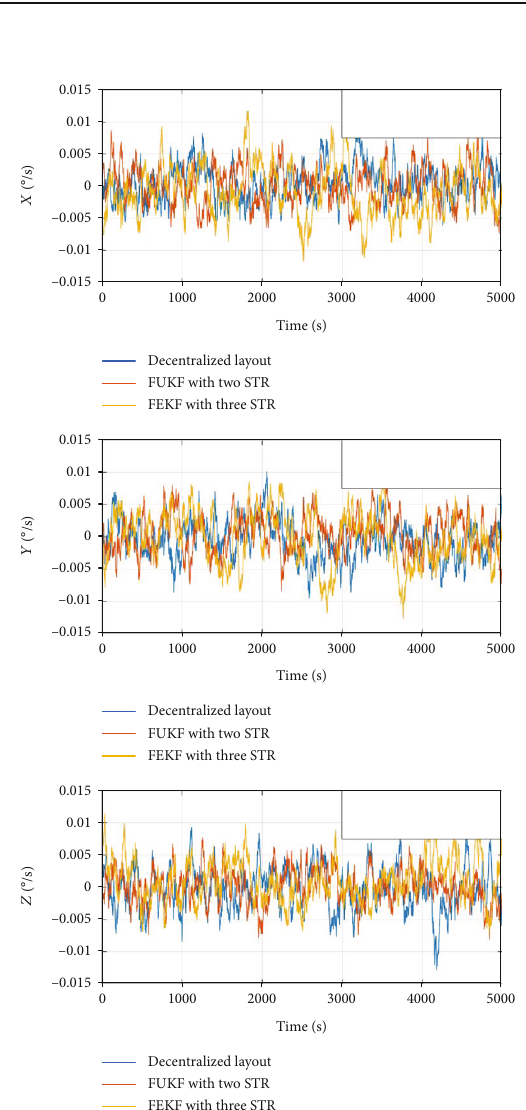
Figure 13: Estimation error of gyro biases (stable phase).